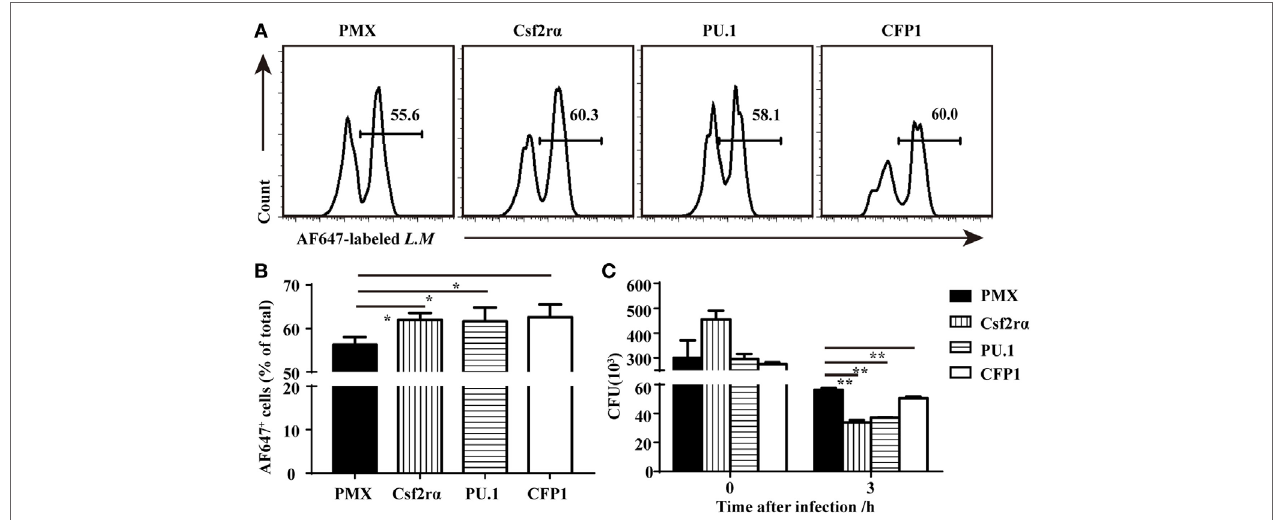
FigUre 6 | Csf2r α partially reversed the defects in the phagocytic and bactericidal activity of Cxxc finger protein 1 (CFP1)-deficient macrophages. (a,B) Flow cytometry analysis of CFP1-deficient (black rectangle) and Csf2r α - (vertical stripe rectangle), PU.1- (horizontal stripe rectangle), and CFP1-reconstituted (white rectangle) macrophages infected for 40 min with AF647-labeled L. monocytogenes (AF647-LM) at a multiplicity of infection (MOI) of 5. (c) Pathogen burden in CFP1-deficient (black rectangle) and Csf2r α - (vertical stripe rectangle), PU.1- (horizontal stripe rectangle), and CFP1-reconstituted (white rectangle) macrophages infected with L. monocytogenes (MOI, 10), presented as colony-forming units (CFU). The mean and SD of four independent experiments are shown. * P < 0.05 and ** P < 0.01 indicate significant differences between groups as determined by Student’s t